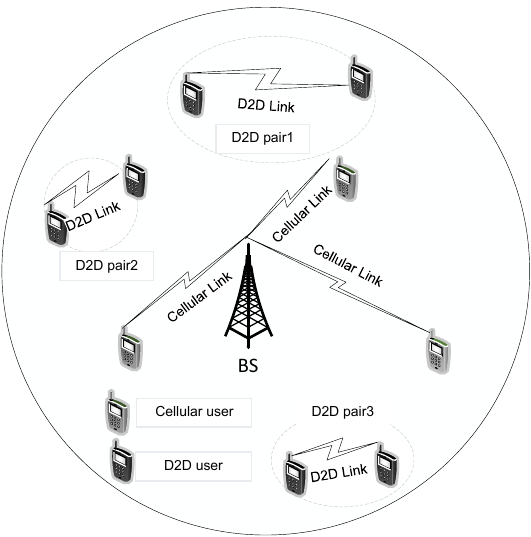
Figure 1. A D2D-enabled cellular